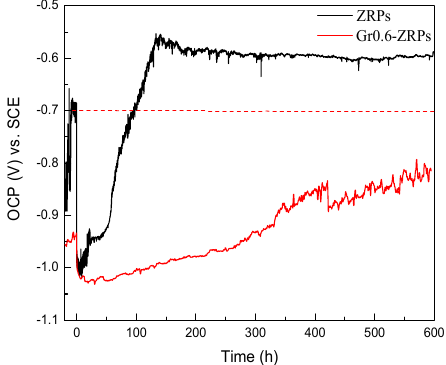
Figure 5. OCP-time measurement of ZRPs and Gr0.6-ZRPs in a 3.5% NaCl solution during 600 h of immersion.